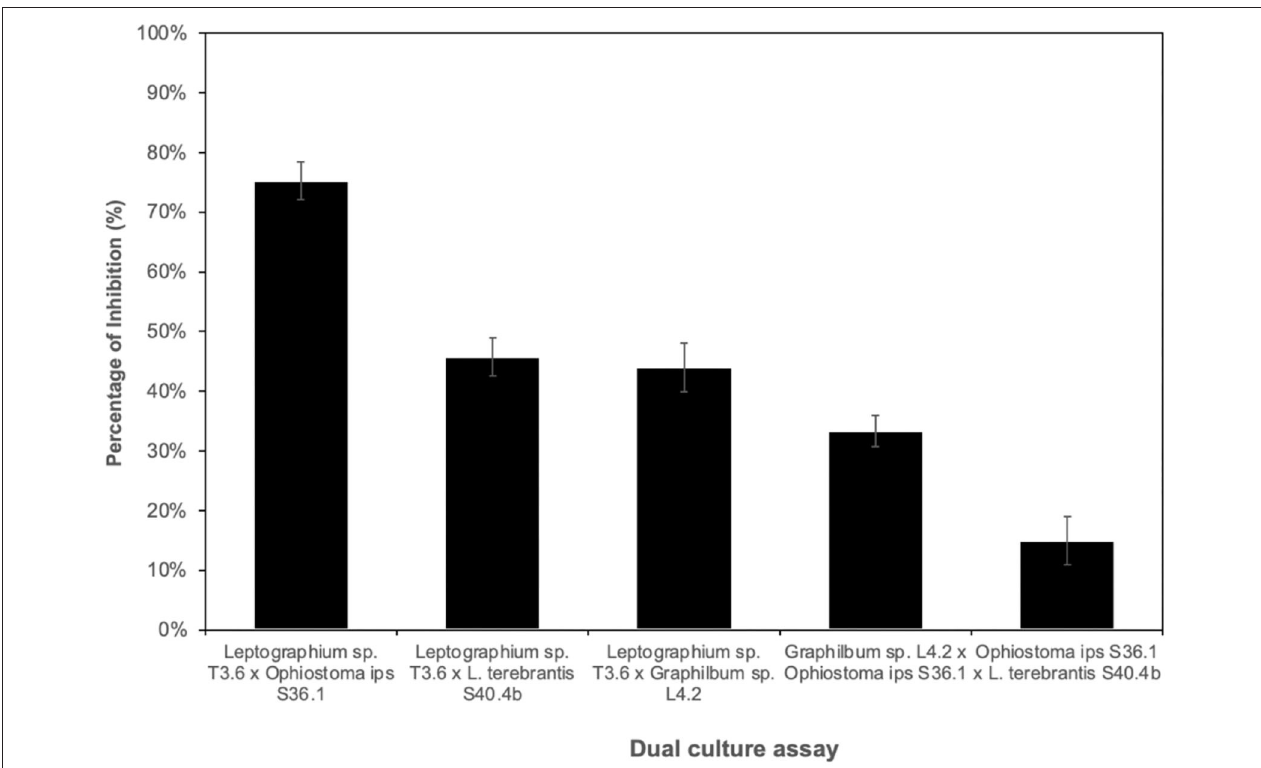
FIGURE 5 | Percentage of inhibition of the potential antagonist x tested organism (grown at 25 ◦ C for 5